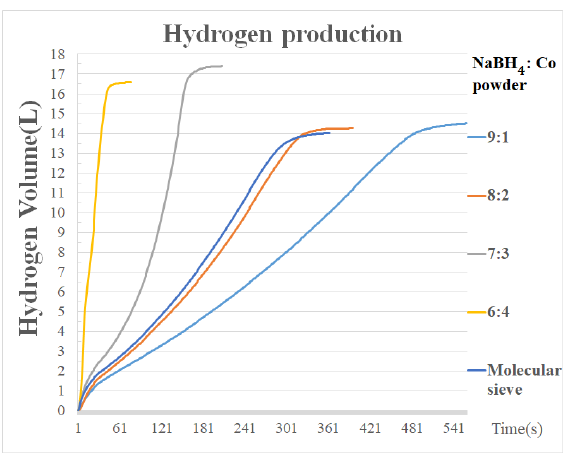
Figure 4. Comparison of the ball milling hydrogen production rates of NaBH 4 + Co 2+ in different ratios.